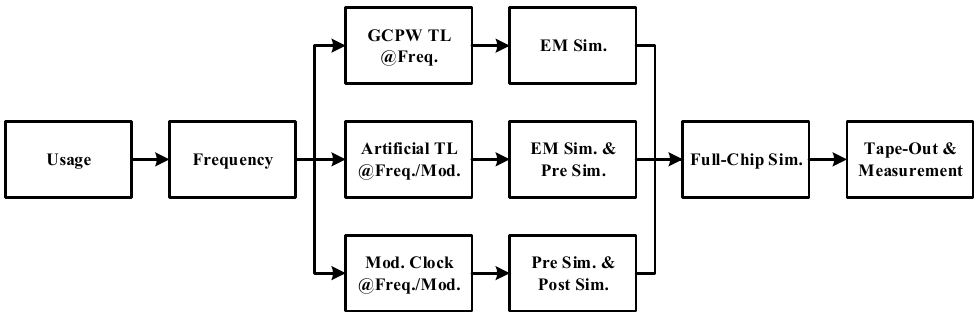
Figure 4. Comprehensive research framework of proposed circulator.